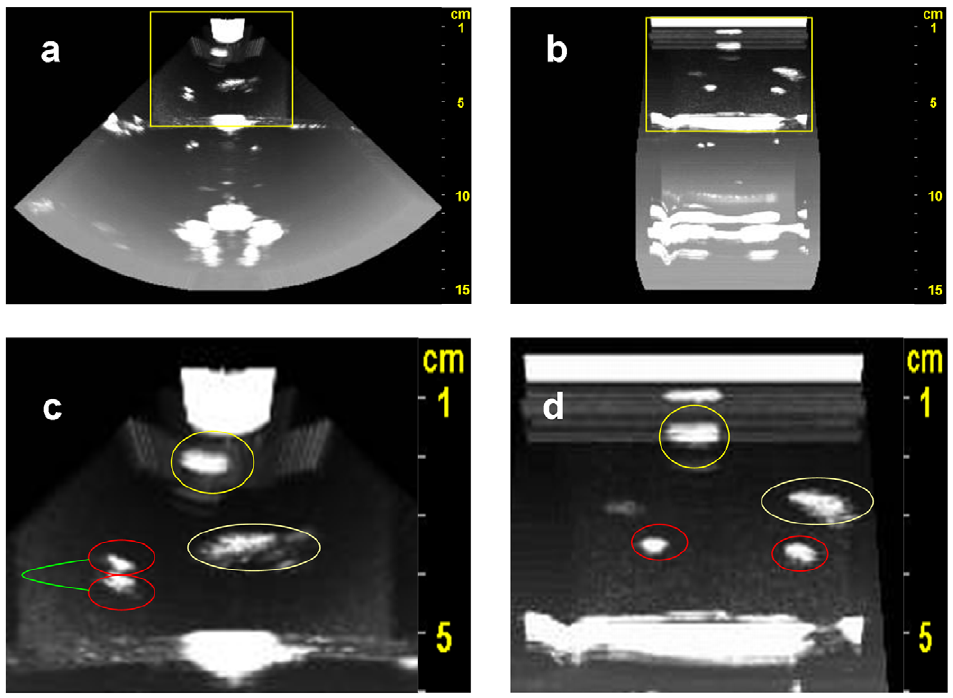
Figure 4. Resulting 3D Volume Visualized. (a) Front projection, axial angle 0 u , depth of 15 cm (b) Side projection, axial angle 90 u , depth of 15 cm (c) Zoom on ROI from (a): the cherry pits, the peach pit and the marble ball are clearly seen. (d) Zoom on ROI from (b) the cherry pits, the peach pit and the marble ball are clearly seen. doi:10.1371/journal.pone.0007974.g004 PLoS ONE |